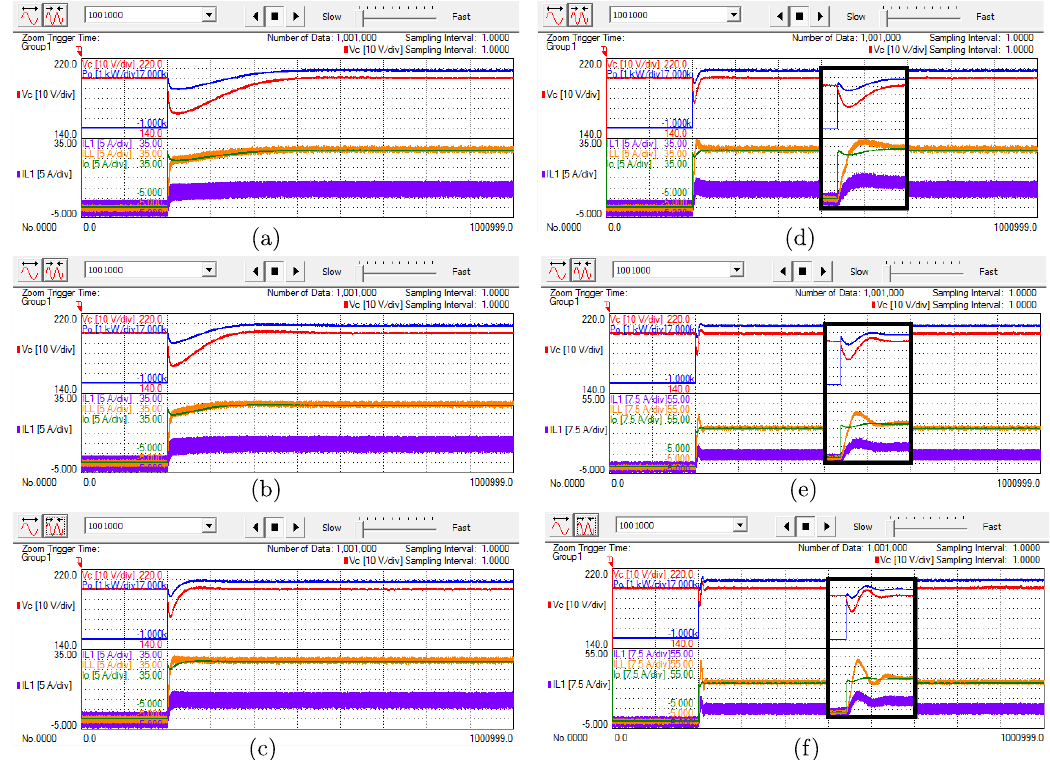
Figure 21. DC microgrid operation as a response to a 5.6 kW load connection for different values of γ . ( a ) γ = ω c ; ( b ) γ = ω c ; ( c ) γ = ω c ; ( d ) γ = ω c ; ( e ) γ = ω c and ( f ) γ = ω c . In these figures, the time 50 5 2 100 10 1 axis has 50